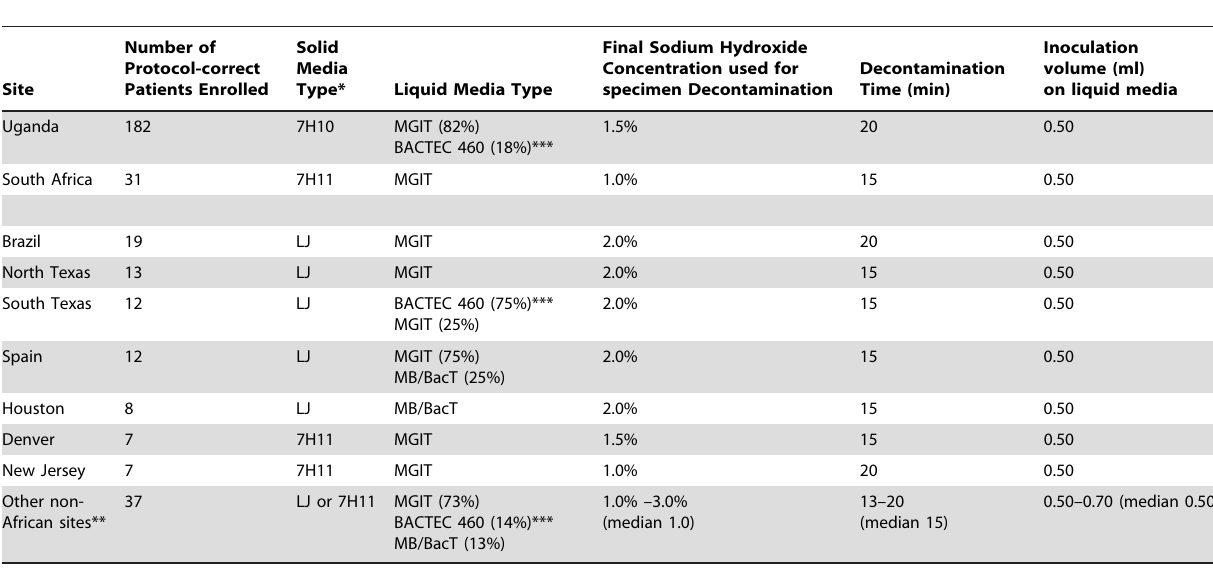
Table 3. Tuberculosis sputum specimen processing and culture practices from the highest enrolling sites of protocol-correct patients, TBTC Study 28.